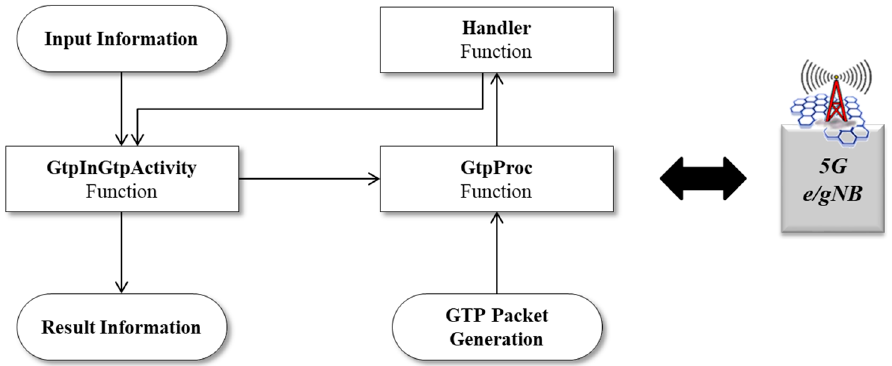
Figure 9. Structure of Android application for 5G security threat assessment.